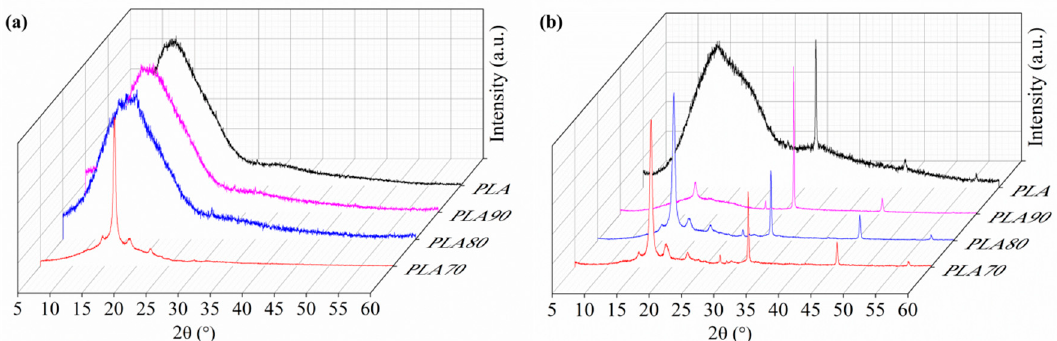
Figure 10. XRD pattern of neat PLA and each of the PLA:OLA electrospun samples: ( a ) before starting the degradation test and ( b ) after 84 days of immersion in PBS.